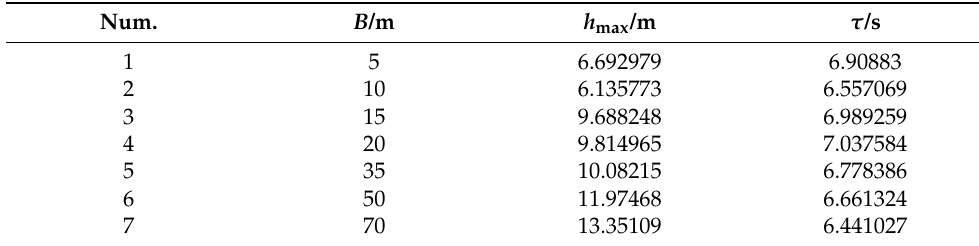
Table 1. Fitting results of h max and τ .